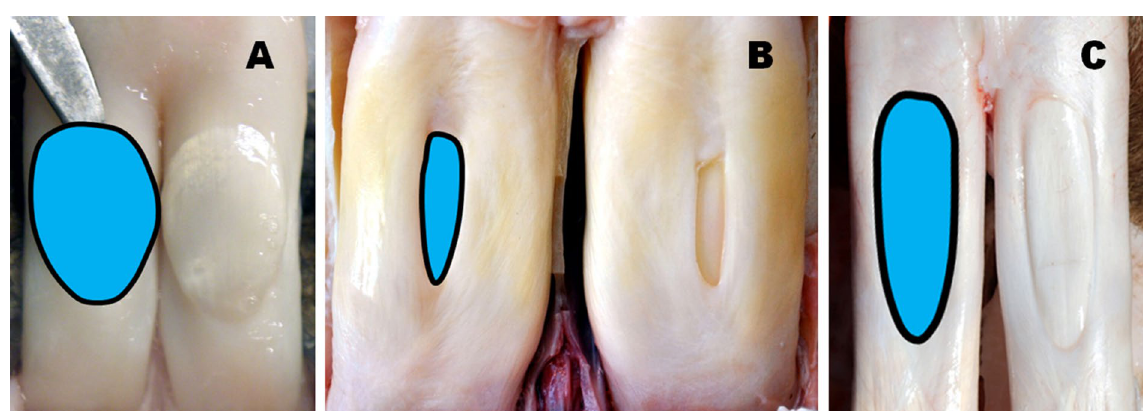
Figure 3. Variable shapes of the “oval window” in the manica flexoria of the pectoral limb (view of the adductor area). ( A ) Western sitatunga, ( B ) European bison, ( C ) Giraffe. Photos by M.